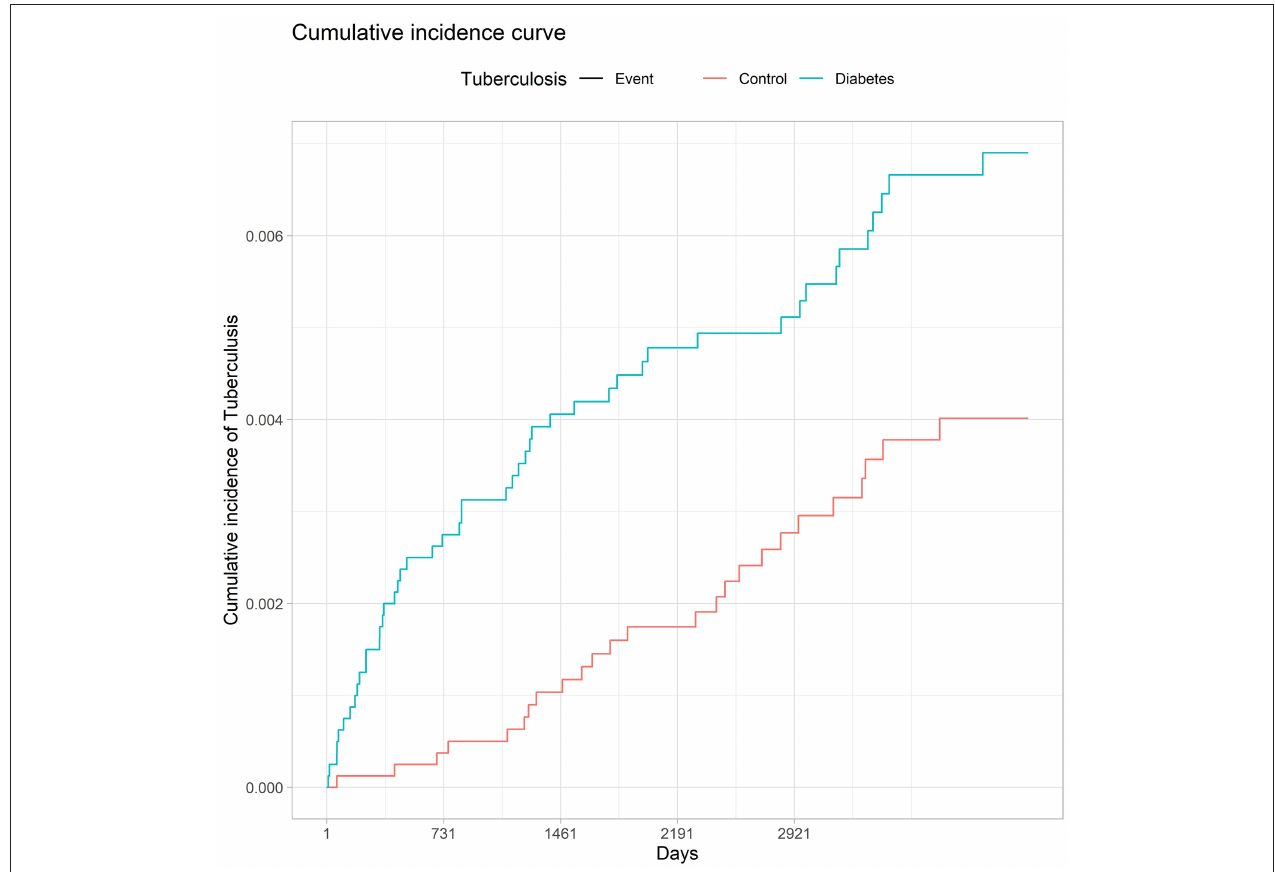
FIGURE 3 | Incidence of tuberculosis in diabetic and non-diabetic patients.